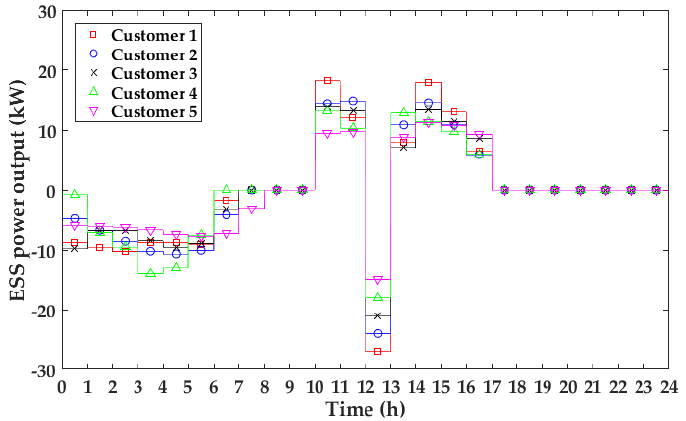
Energies 2016 , 9 , 558